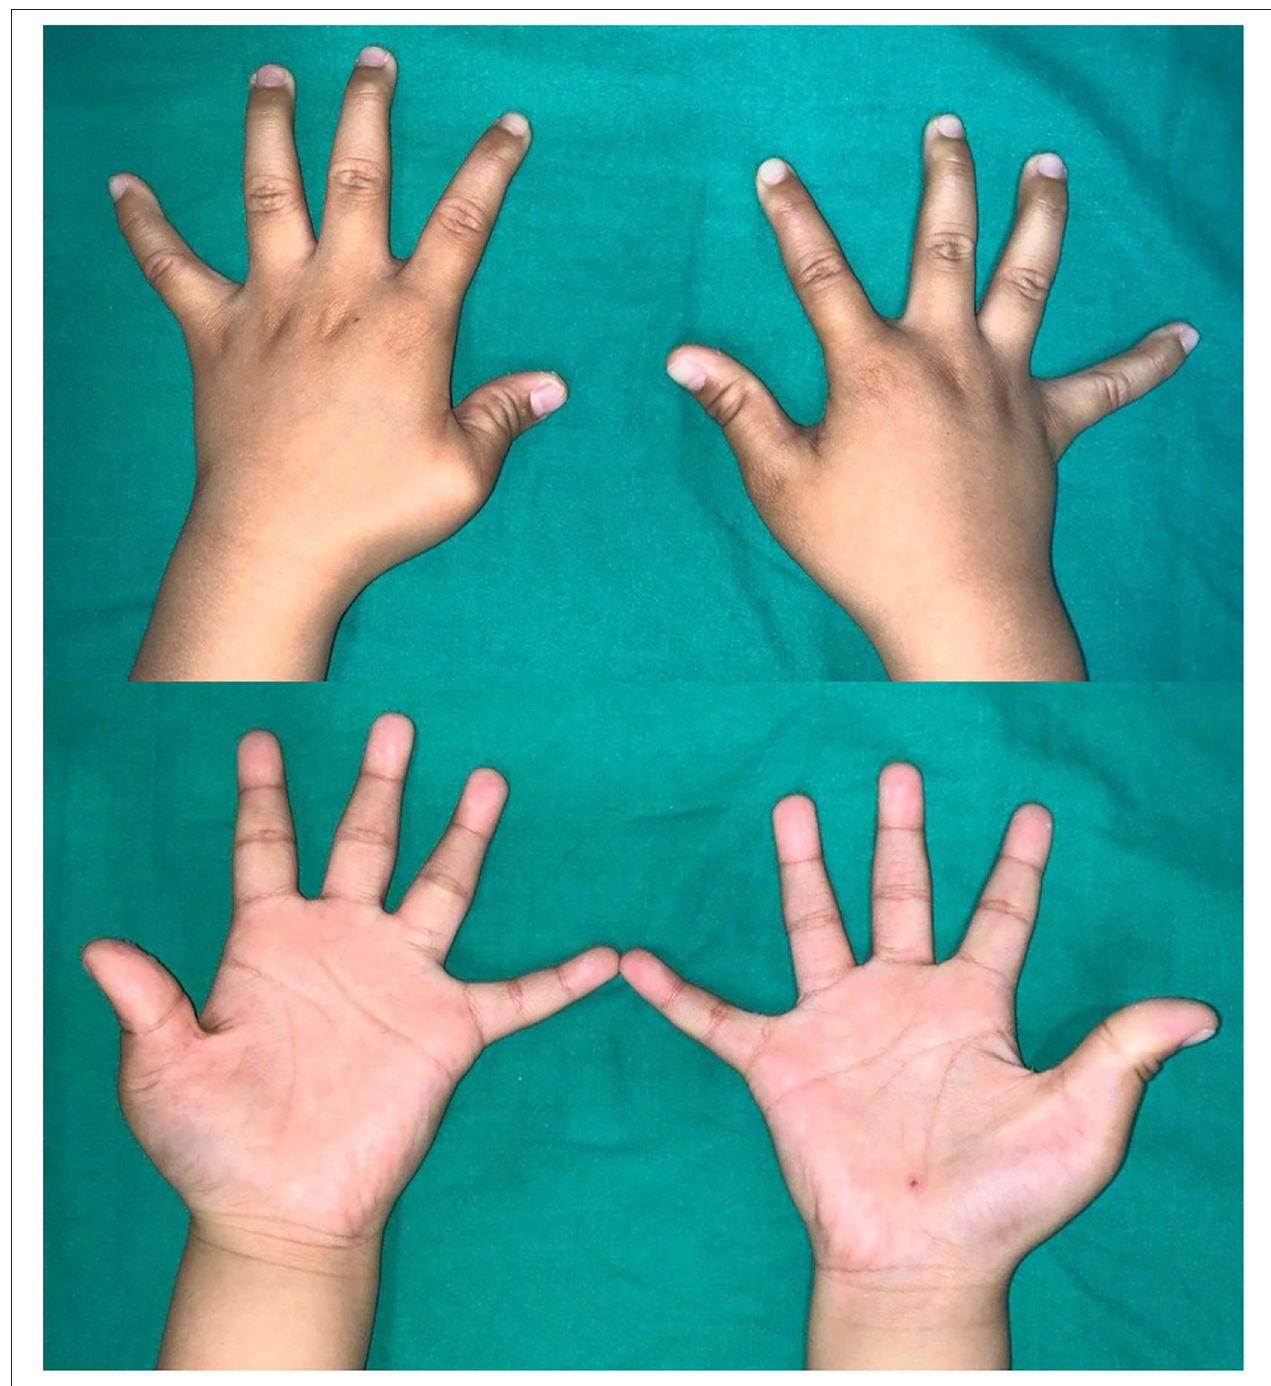
FIGURE 1 | Adduction and flexion deformities on both thumbs.